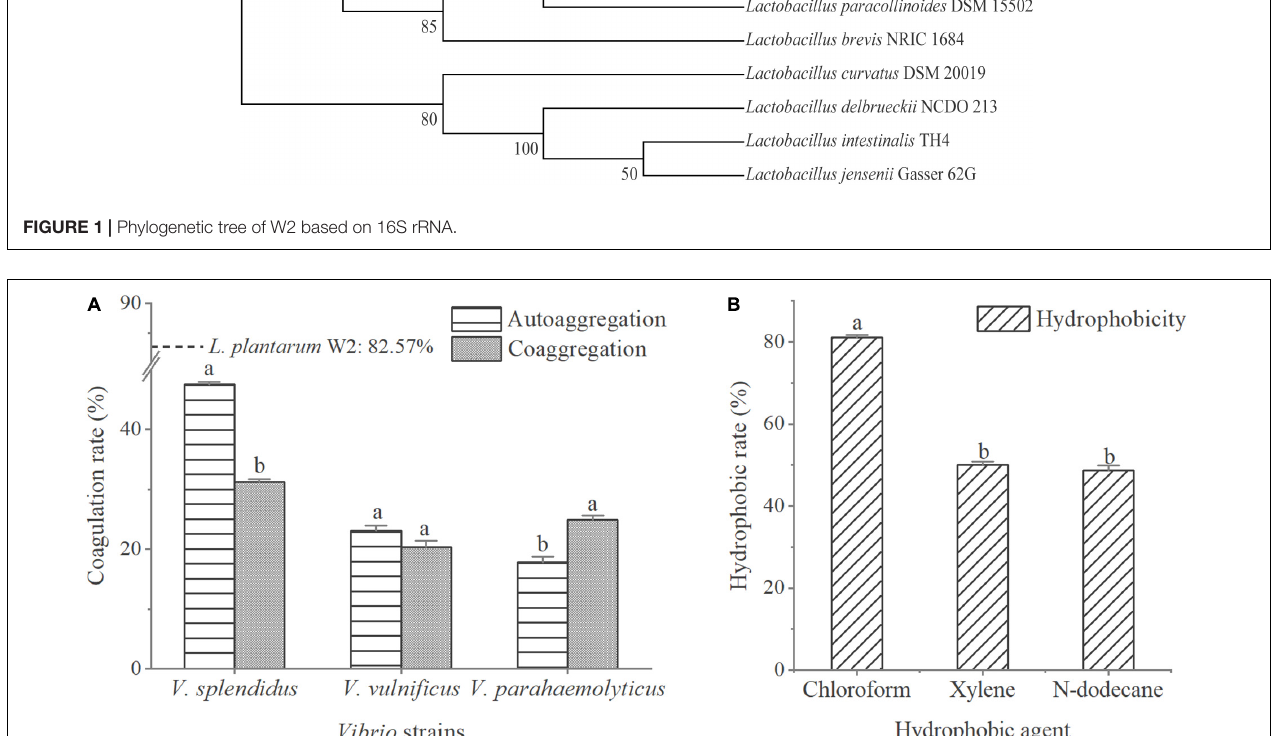
FIGURE 2 | Adhesion properties of L. plantarum W2. (A) Autoaggregation rates of three Vibrio strains ( V. splendidus BSD11, V. vulnificus S01P2, V. parahaemolyticus 20130629002S01) and their coaggregation rate with W2. Autoaggregation rate of W2 is indicated by a dotted line. (B) W2 adherence to